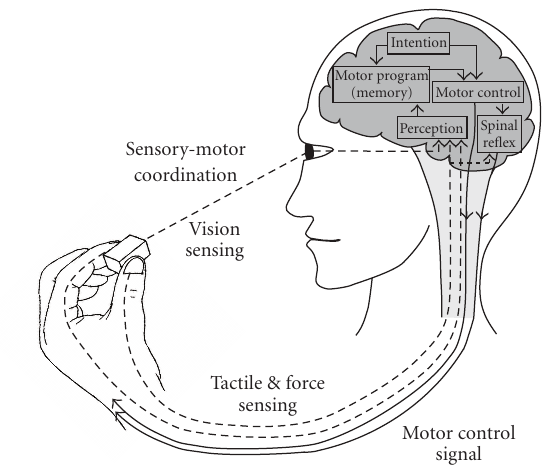
Figure 12: Sensory-motor